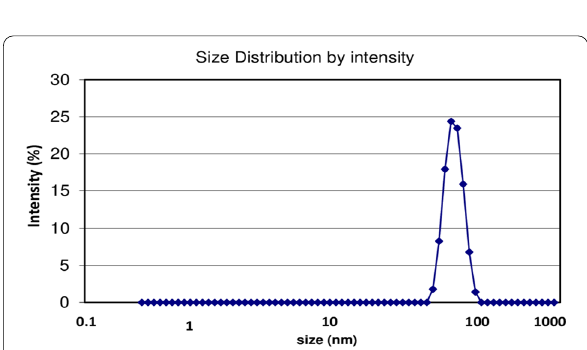
Fig. 4 Average size distribution by intensity of AmB-CNPs by using dynamic light scattering technique Fig. 5 Zeta potential distribution of amphotericin B-loaded chitosan nanoparticles